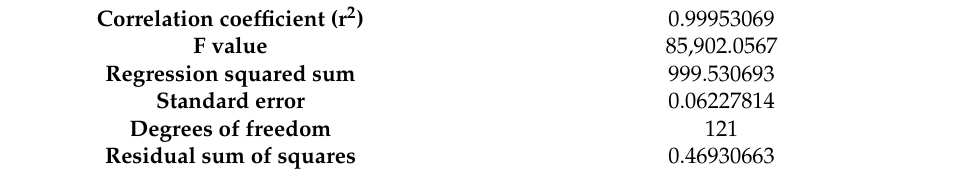
Table 4. Linear regression